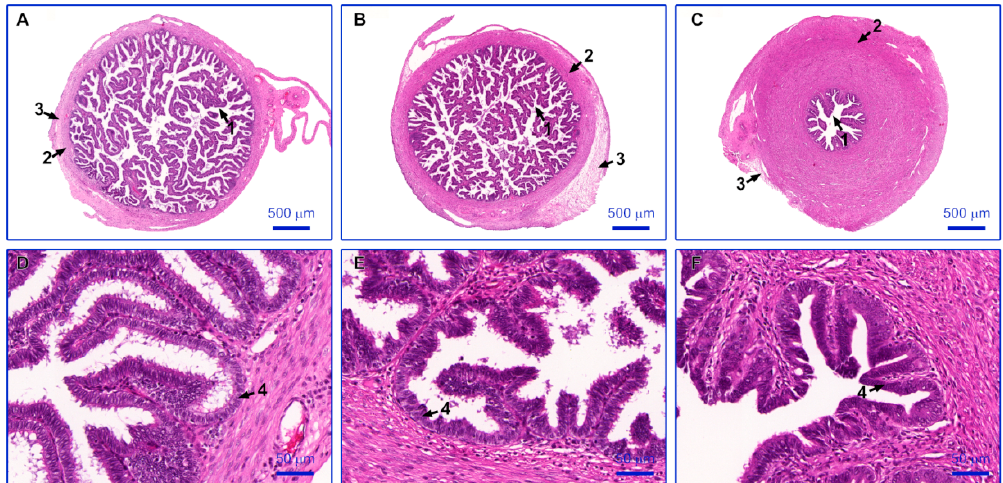
Figure 1. Representative sections of porcine oviducts stained with hematoxylin and eosin. ( A ) the infundibulum, ( B ) the ampulla, ( C ) the isthmus, ( D – F ) epithelium lining the mucosal folds, in the infundibulum, the ampulla and the isthmus, respectively. Arrows: 1: mucosal folds, 2: muscle layer, 3: serosa, and 4: simple columnar ciliated epithelium.